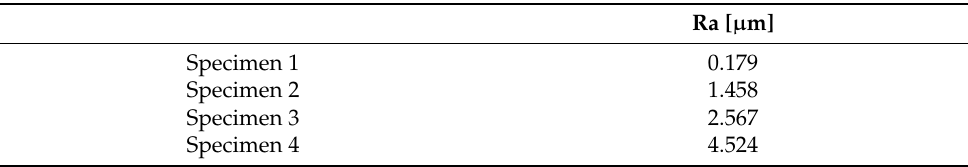
Table 1. Roughness of four specimen sets.